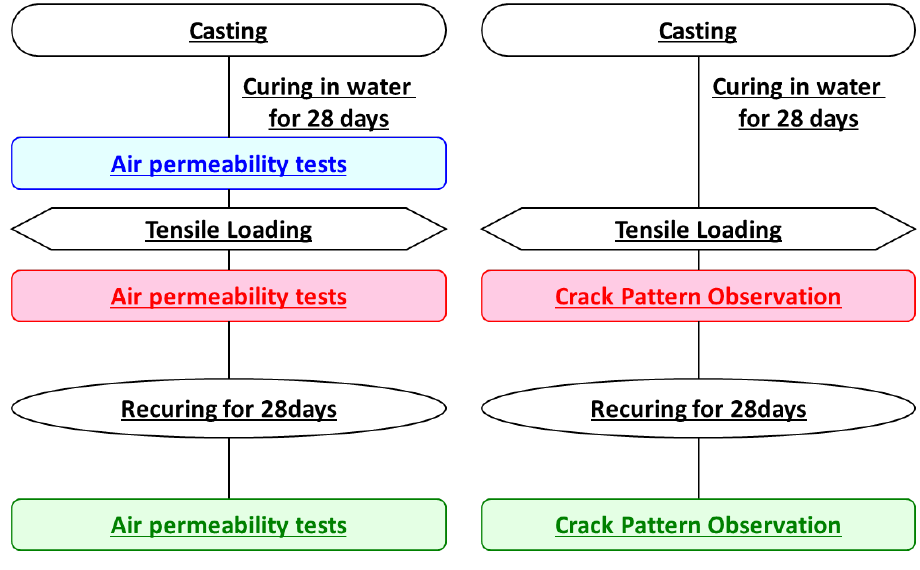
Figure 8. Experimental